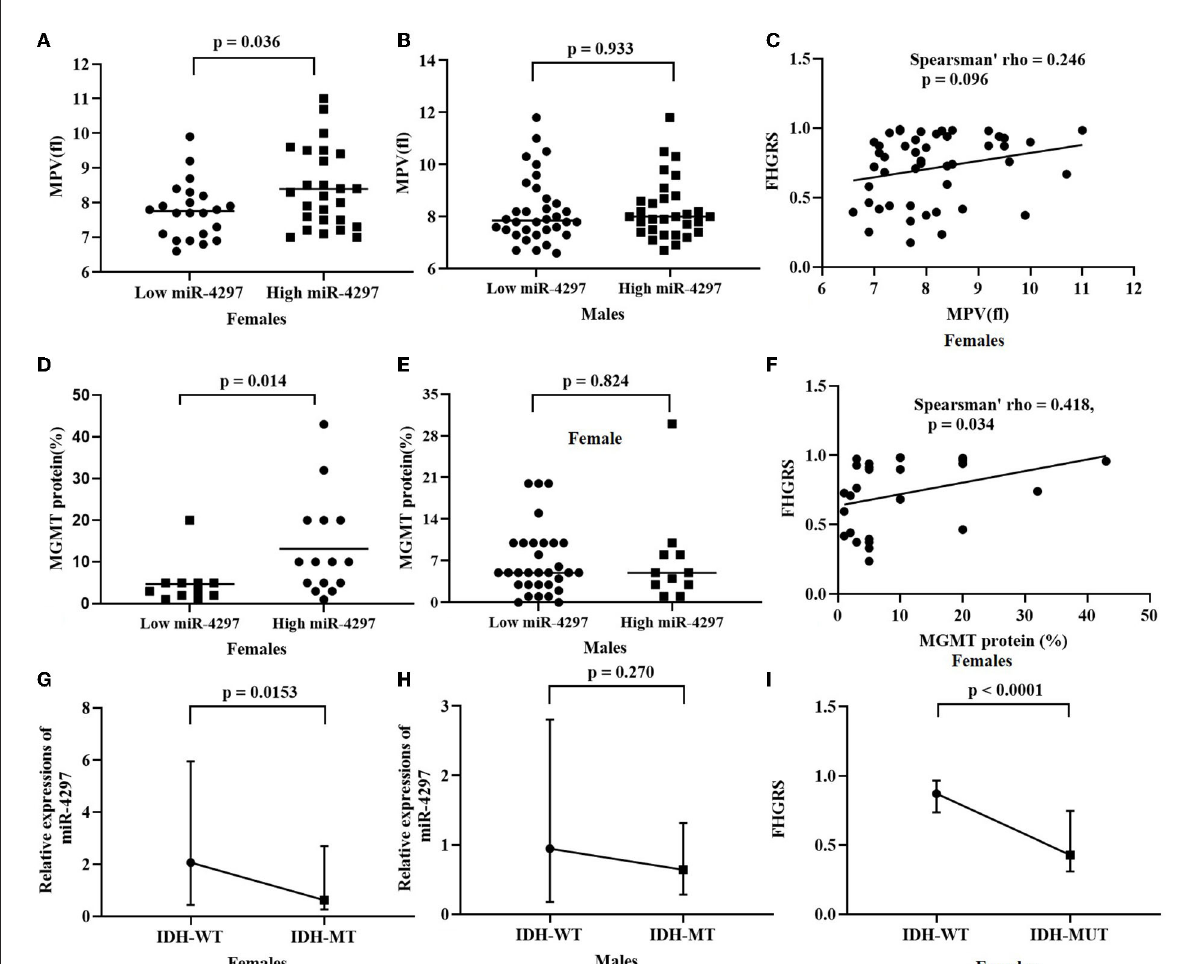
FIGURE2 Sex-dependent analysis of serum miR-4297 and FHGRS. (A) Rather than FHGRS, statistically significant correlates are observed between miR-4297 levels and MPVs in female patients; (B) MGMT protein correlates with miR-4297 levels and FHGRS in females; (C) IDH-MT female patients have significantly decreased levels of miR-4297 and FHGRS. MPV , mean platelet volume ; MGMT, O6-methylguanine-DNA methyltransferase; WT, wild type; MT , mutant